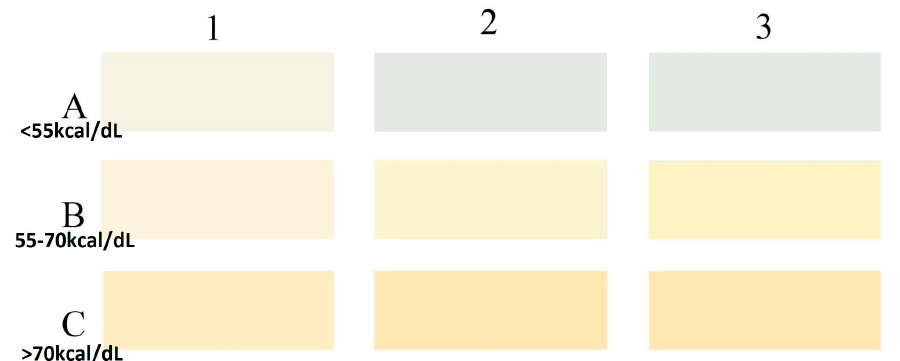
Figure 2. HCMG tool with 9 color shades (October 2019 version). Note: colors from www.Behr.com